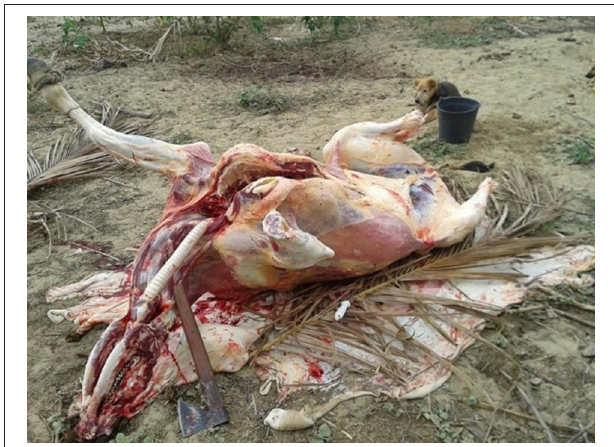
FIGURE 2 | Environmental damage and bad hygienic conditions of a clandestine bovine slaughter